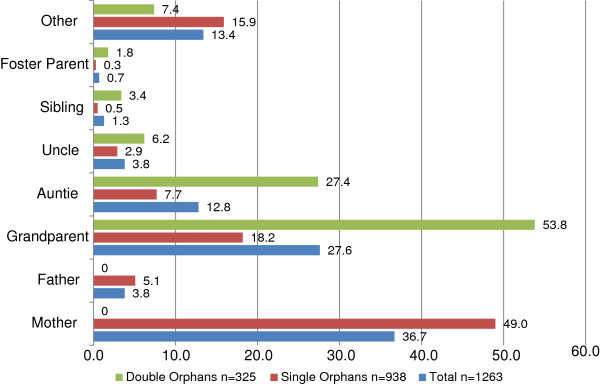
Percentage of orphaned and separated children living with specified primary caregiver from 300 family-based environments. (Note: additional adults may be living in the household)